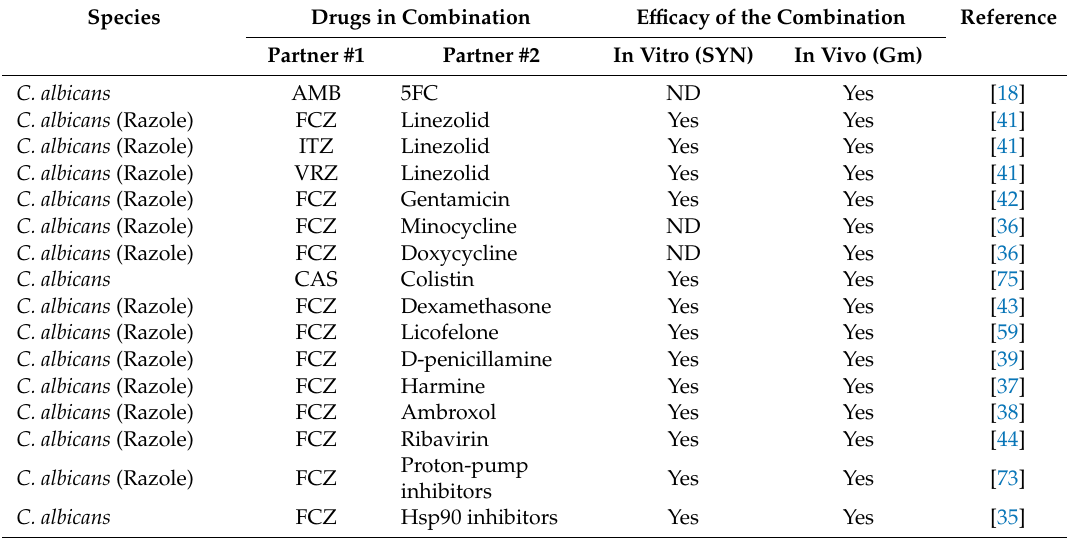
Table 2. Evaluation of antifungal combination e ffi cacy against Candida spp. in G.